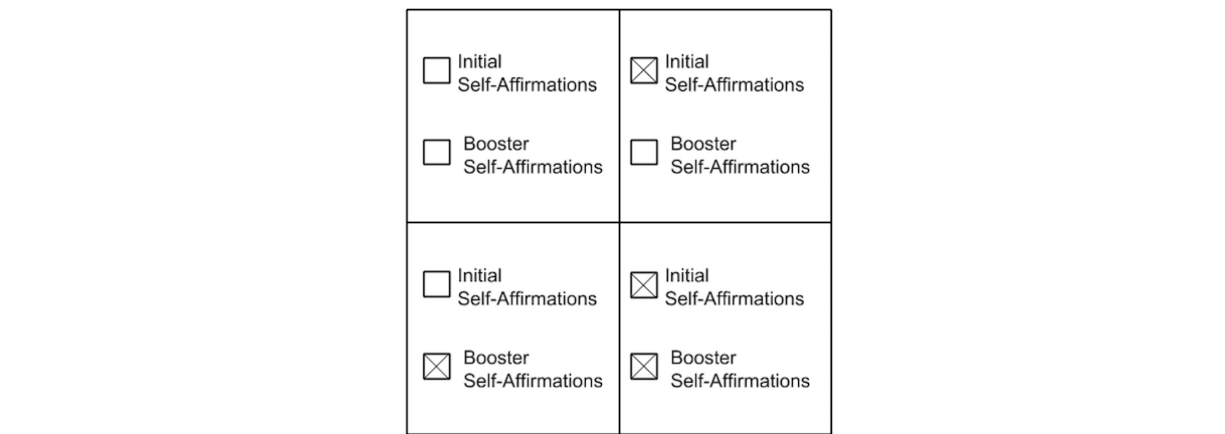
Figure 1. The 2x2 experimental design demonstrates the different independent variables across the